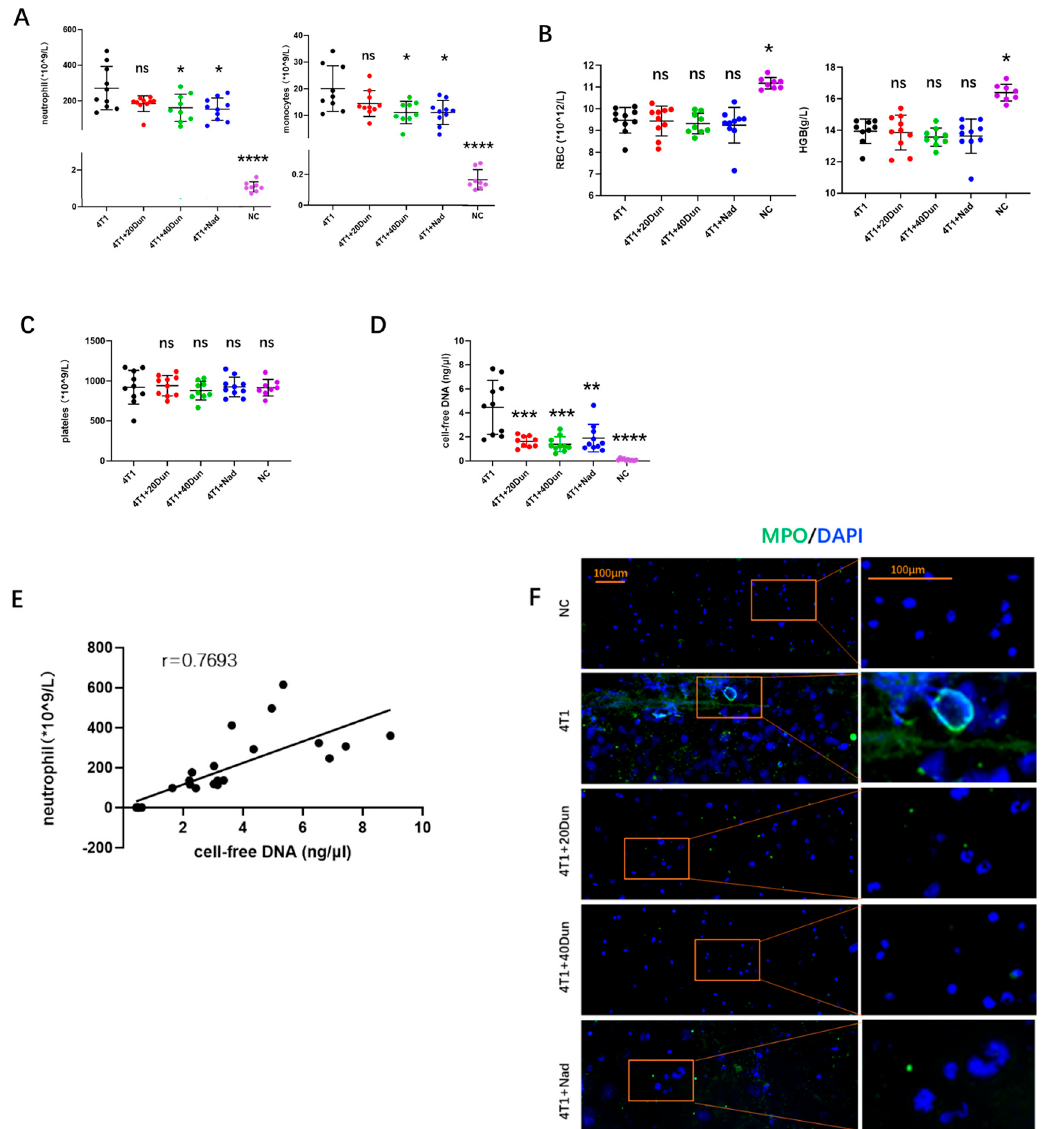
Figure 2. Dunnione alleviates neutrophilia and increases neutrophil extracellular traps (NETs) in 4T1 tumor − bearing mice. ( A ) Peripheral neutrophil and monocyte counts were measured by an automated hematology analyzer in each group ( n = 8 − 11 per group). ( B ) Comparison of red blood cell (RBC) and hemoglobin (HGB) levels in each group ( n = 8 − 11 per group). ( C ) Comparison of platelet counts in each group ( n = 8 − 11 per group). ( D ) Systemic levels of cell − free DNA were detected by Quant − iT PicoGreen dsDNA kit in the plasma of each group ( n = 8 − 10 per group). ( E ) Correlation of peripheral neutro- phil counts and plasma cell − free DNA in mice of all groups ( n = 24). ( F ) Myeloperoxidase (MPO) (green) combined with 4 ′ , 6 − diamidino − 2 − phenylindole (DAPI) (blue) staining of neutrophils isolated from the mice in each group ( n = 4). Neu- trophils were simulated with 500 ng/mL lipopolysaccharide (LPS) of for 30 min after isolation, and then slides were pre- pared by cytospin. Scale bar, 100 μ m. p -values were obtained by one − way ANOVA. Data represent the mean ± SD. Sig- nificance as compared to the samples of the 4T1 group. ns, not significant; * p < 0.05; ** p < 0.01; *** p < 0.001; **** p < 0.0001.